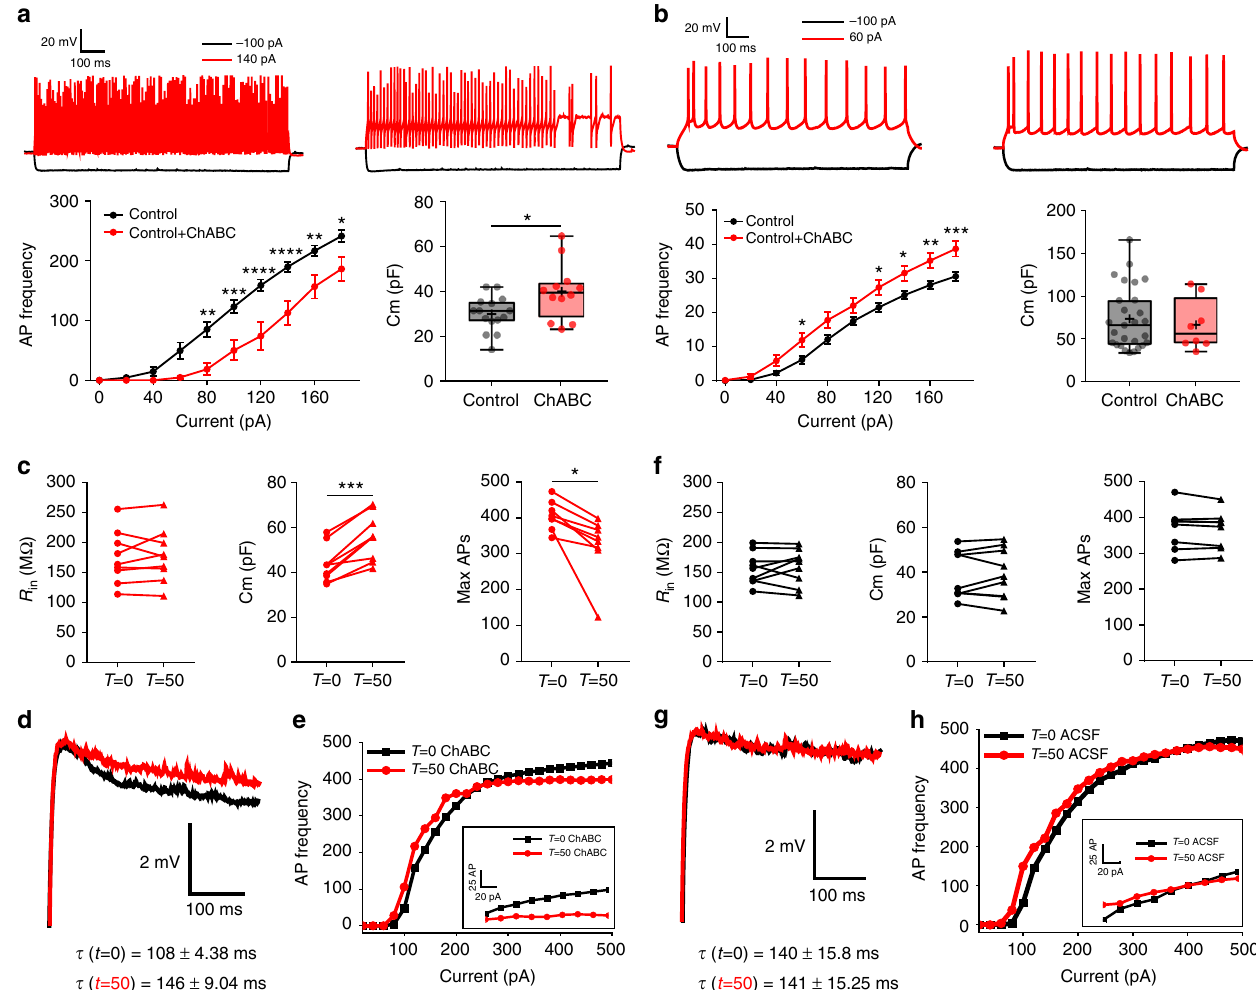
Fig. 8 PNNs modulate the fi ring rate of FSNs by reducing the membrane capacitance. a Representative Vm traces of FSNs in control (upper left) and ChABC-treated slices (upper right) on − 100pA and 140pA current injections. Reduced AP frequency of FSNs in (lower left) ChABC-treated slices ( n = 8 (6)) than in control ( n = 10(7)). Higher Cm (lower right) of FSNs in ChABC-treated slices (39.87 ± 3.56, n = 12(6)) than in control (30.11 ± 1.99, n = 15(8)). b Representative Vm traces of excitatory neurons in control (upper left) and ChABC-treated slices (upper right) on − 100pA and 60 pA current steps. Higher AP frequency (lower left) of excitatory neurons in ChABC-treated slices ( n = 22(8)) than in nontreated controls ( n = 36(10)). Unaltered Cm of excitatory neurons in (lower right) ChABC-treated slices (66.84 ± 10.51, n = 8 (6)) than in control (73.93 ± 6.95, n = 27(8)). c Properties of FSNs during real-time PNN degradation in slices by ChABC ( T = 0, before ChABC; T = 50, 50 min after ChABC superfusion). R in ( T = 0, 175.05 ± 14.60; T = 50, 177.83 ± 14.93; n = 9(7)) remained unaltered; however, Cm ( T = 0, 43.53 ± 2.70; T = 50, 55.76 ± 3.43; n = 9(6)) and max AP frequency ( T = 0, 406.62± 14.39; T = 50, 322.5 ± 30.27, n = 8(6)) changed signi fi cantly. d Representative traces of FSN ’ s Vm decay and e AP frequency before (black) and after (red) ChABC treatment. τ = membrane time constant. f Electrophysiological properties of FSNs during ACSF superfusion did not change. R in ( T = 0, 156.07 ± 8.96; T = 50, 158.98 ± 9.94; n = 9(6)), Cm ( T = 0, 38.74 ± 3.51; T = 50, 39.33 ± 3.75; n = 9(6)), and AP frequency ( T = 0, 368 ± 20.90; T = 50, 364.5 ± 18.83; n = 8 (6)). g Representative traces of FSN ’ s Vm decay and h AP frequency before (black) and after (red) 50 min of ACSF treatment. τ = membrane time constant. n = cells(mice) in all. The units for membrane potential (Vm), membrane capacitance (Cm), and input resistance ( R in ) are mV, pF, and M Ω , respectively. **** P < 0.0001, *** P < 0.001, ** P < 0.01, * P < 0.05, two-way ANOVA, Sidak ’ s post-hoc test in bottom left ( a and b ); unpaired t test in bottom right ( a and b ); and paired t test in ( c ) and ( f